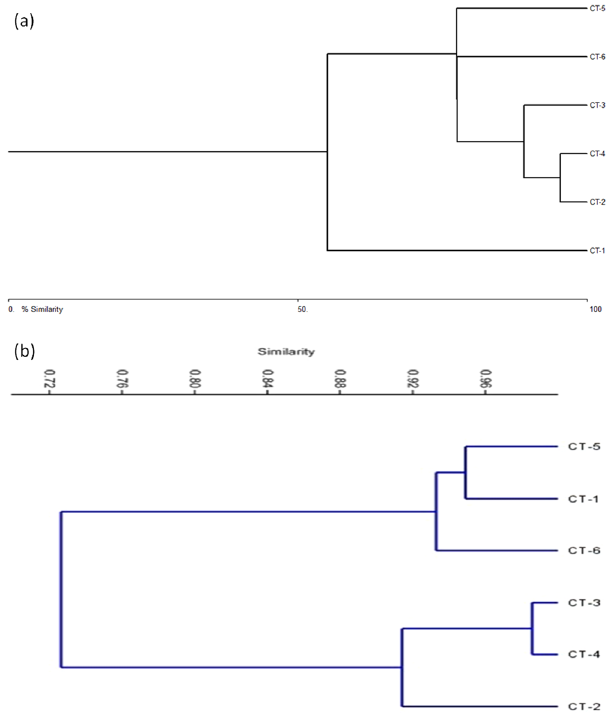
Figure 4. ISSR data ( a ) and FTIR absorbance ( b ) based clustering of C. tora